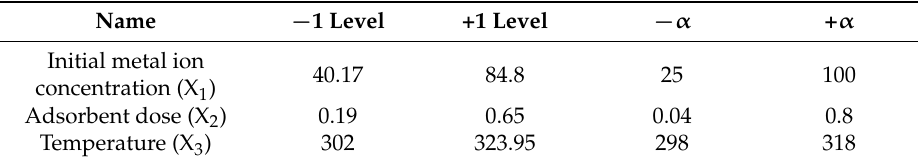
Table 3. Detail scope of experiments and range of the operating